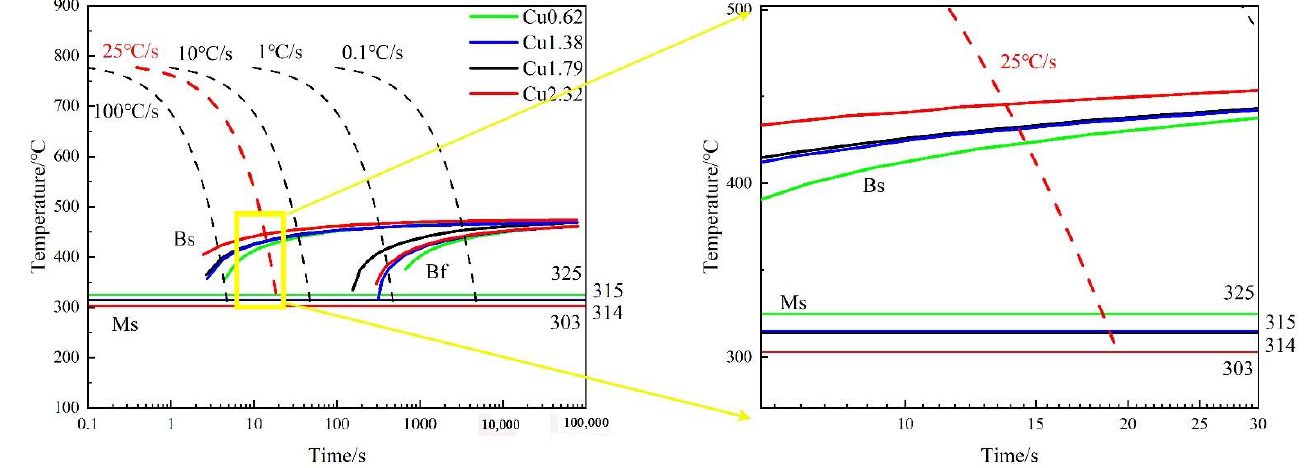
Figure 10. Continuous cooling transformation curves of deposited metals. The difference values ( Δ ) of Bs and Ms point increases with increase of Cu addition.